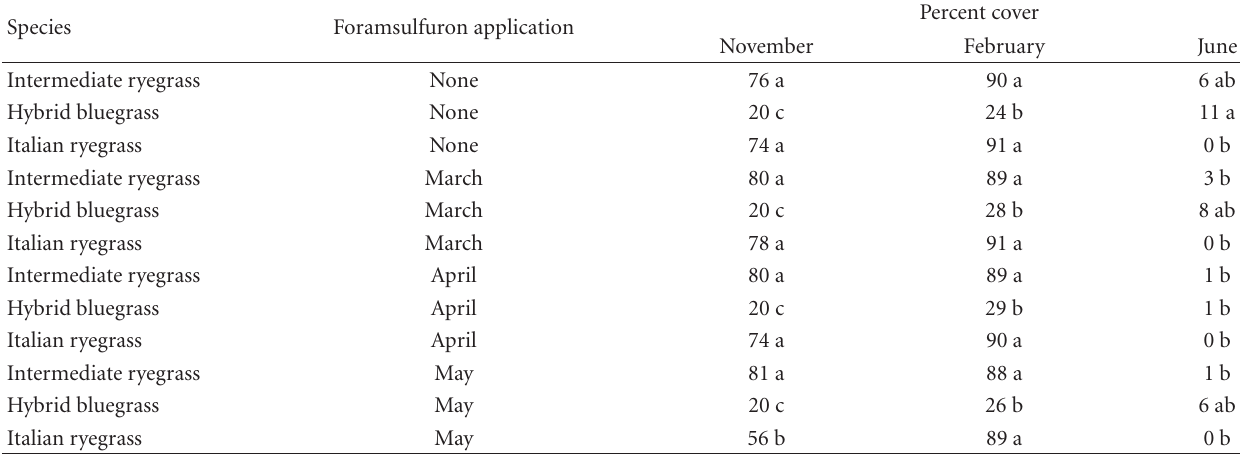
Table 4: Percent cover as a ff ected by overseeded species and foramsulfuron application timing in 2004 for the second experiment. a